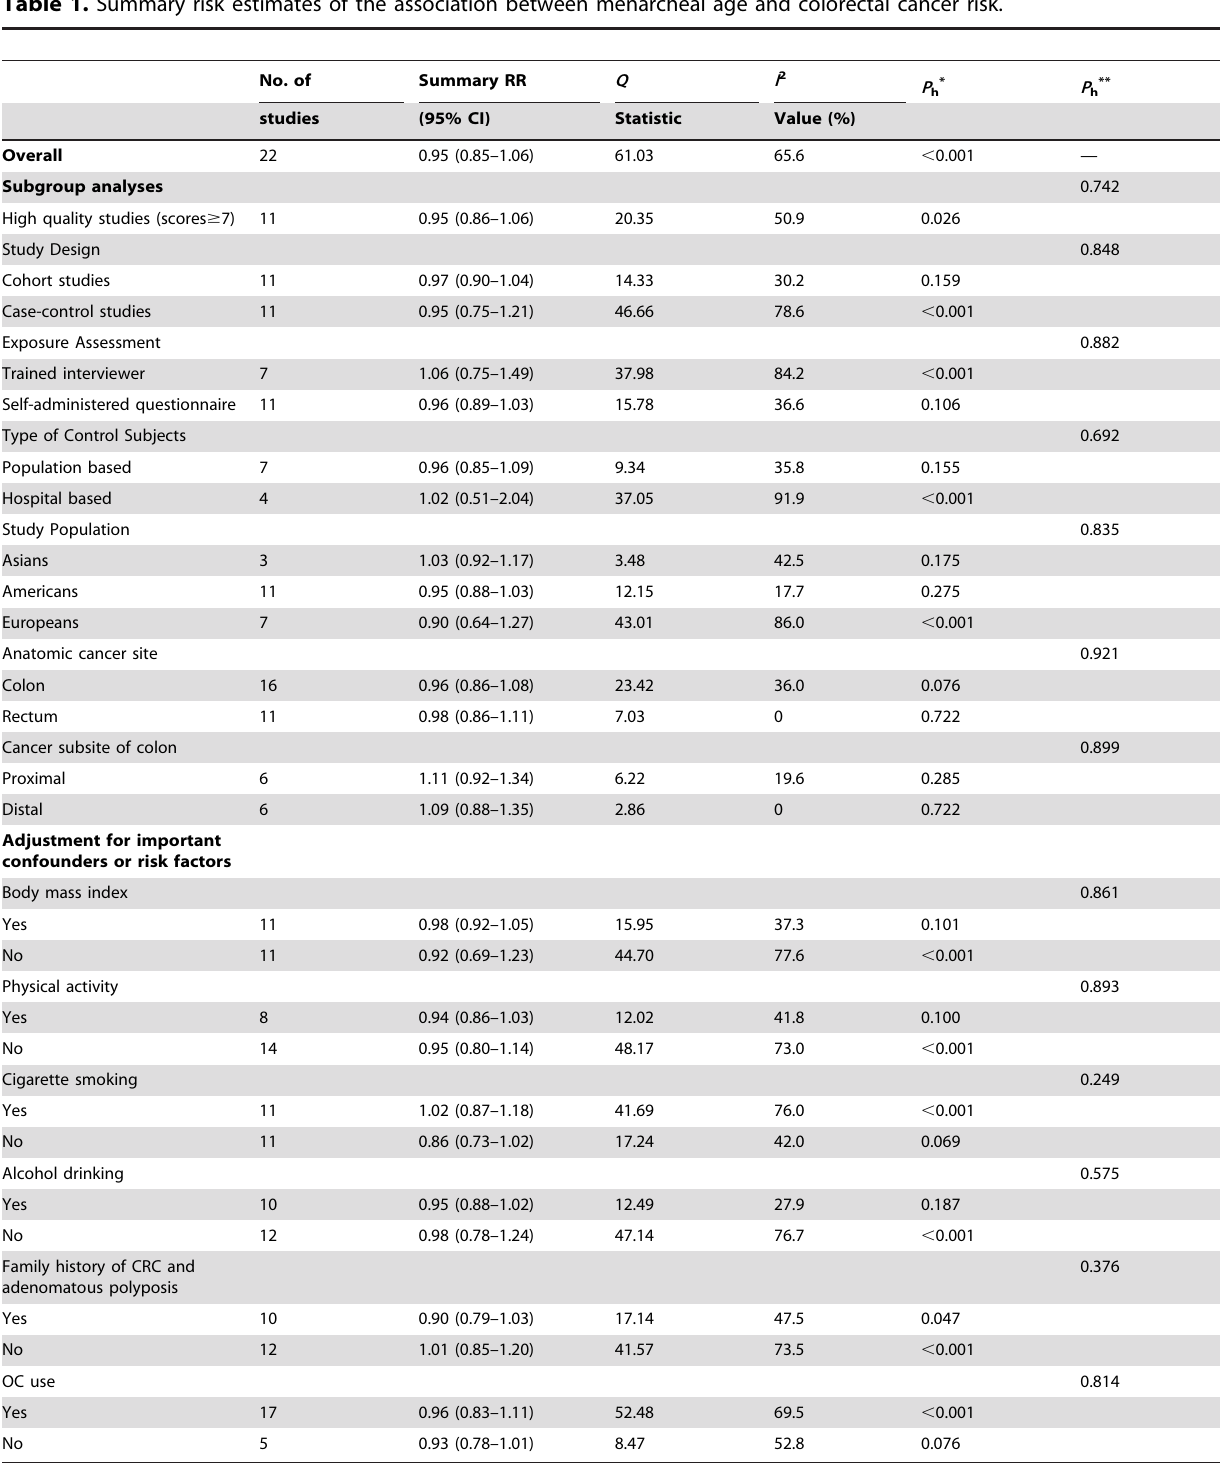
Table 1. Summary risk estimates of the association between menarcheal age and colorectal cancer risk.